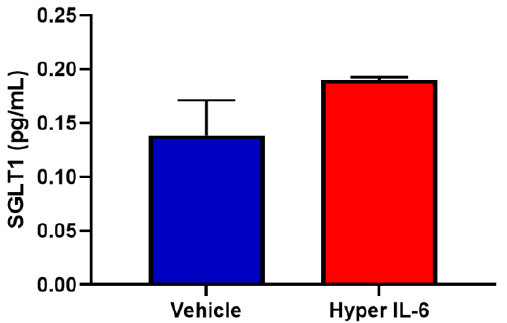
Figure 8. Hyper IL-6 promotes SGLT1 expression in HK2 cells. Cells were treated with vehicle or Hyper IL-6 for 24 h; data represented as mean ± SEM; n = 3/group.